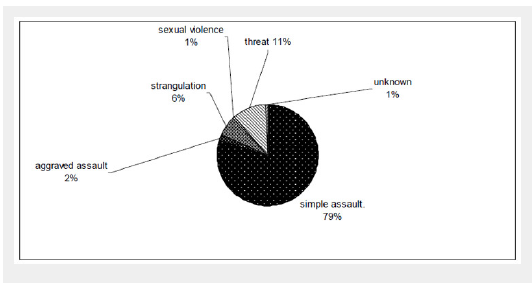
Localisation of the injuries in the region of the head and neck.